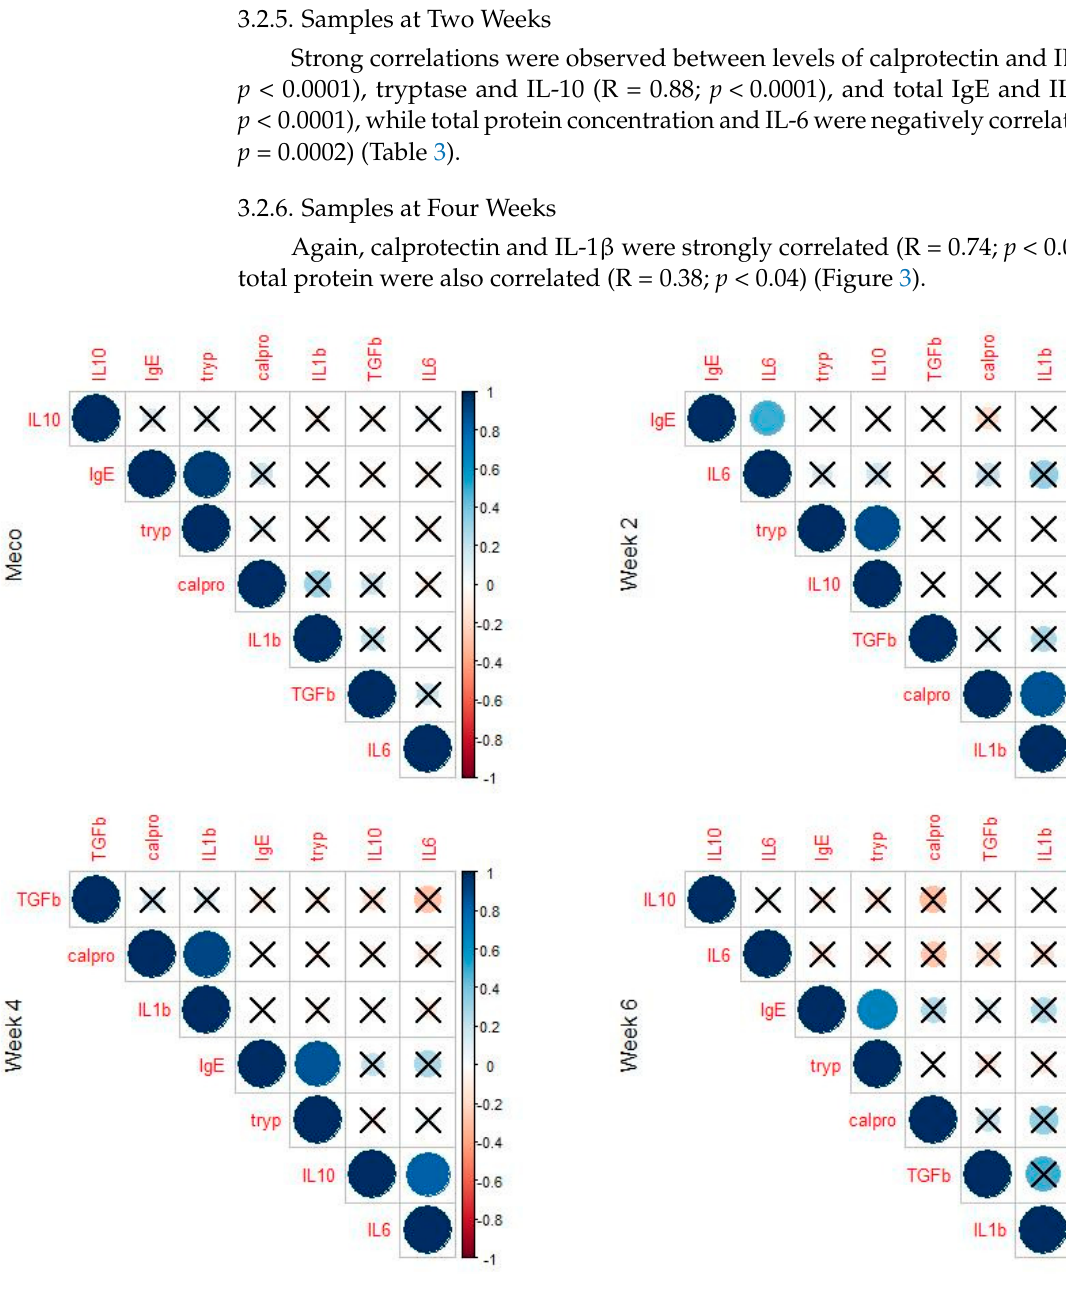
Figure 4. Correlation figure of fecal immune biomarkers. Figure 3. Correlation figure of fecal immune